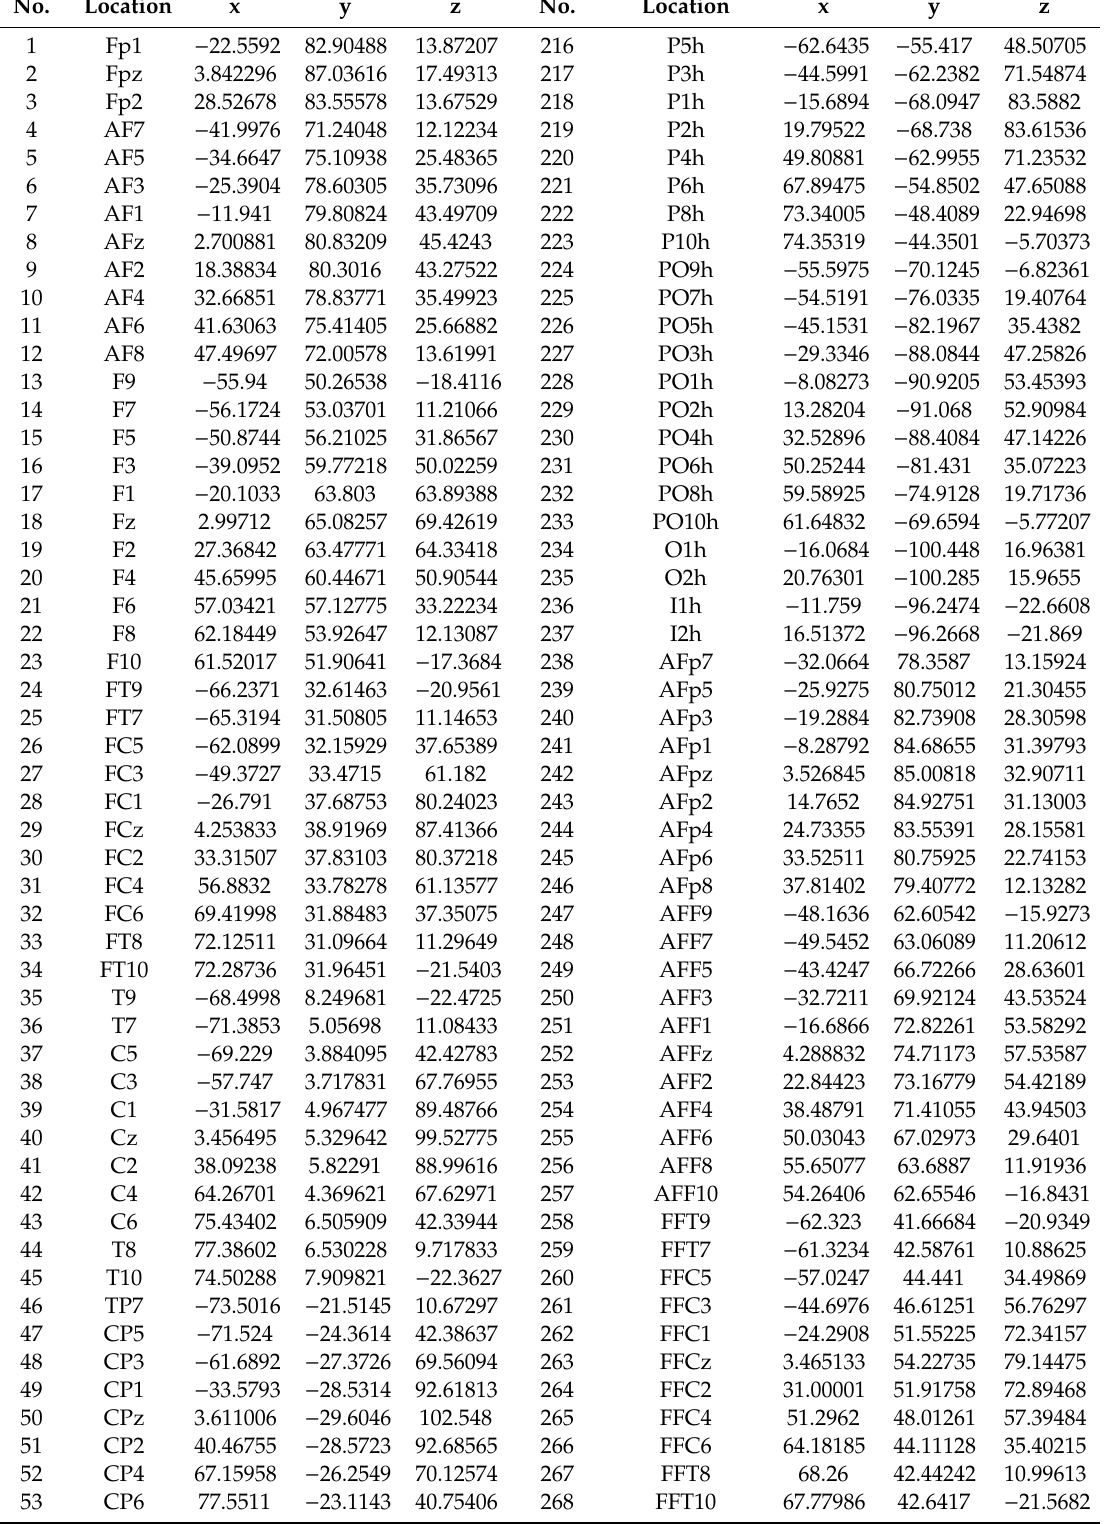
Table A2. 429 electrode locations (including fiducials and reference electrodes) with the X, Y, Z for 55–59 years head model